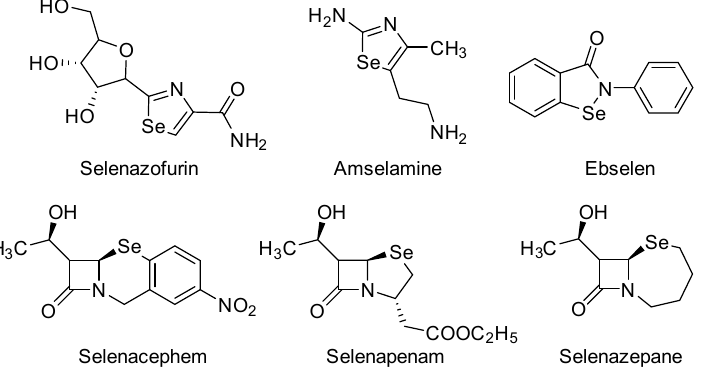
Figure 1. Biologically active organoselenium compounds.